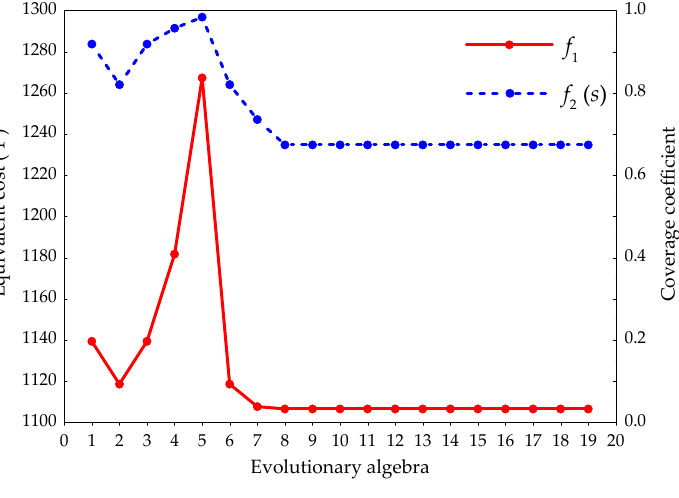
Figure 2. Iterative trend curve.